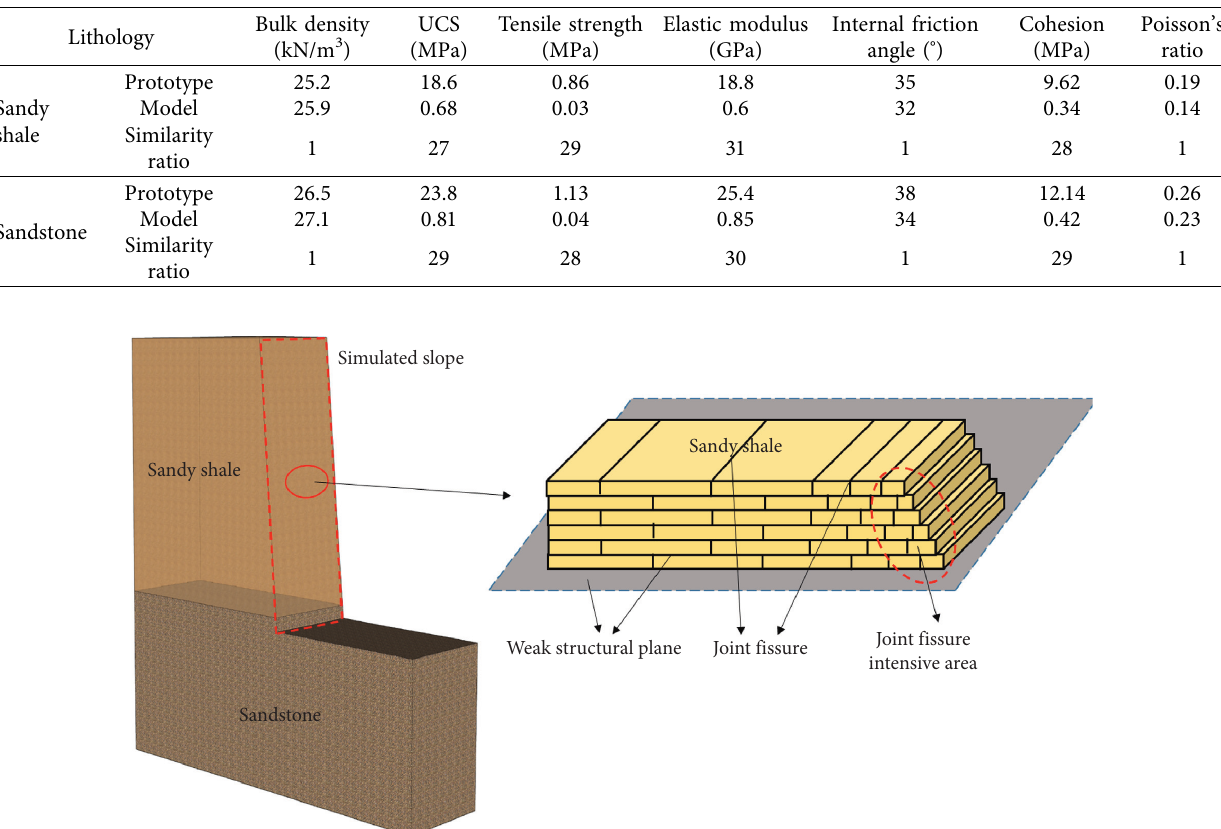
Table 1: Physical and mechanical parameters of rock mass and model materials.